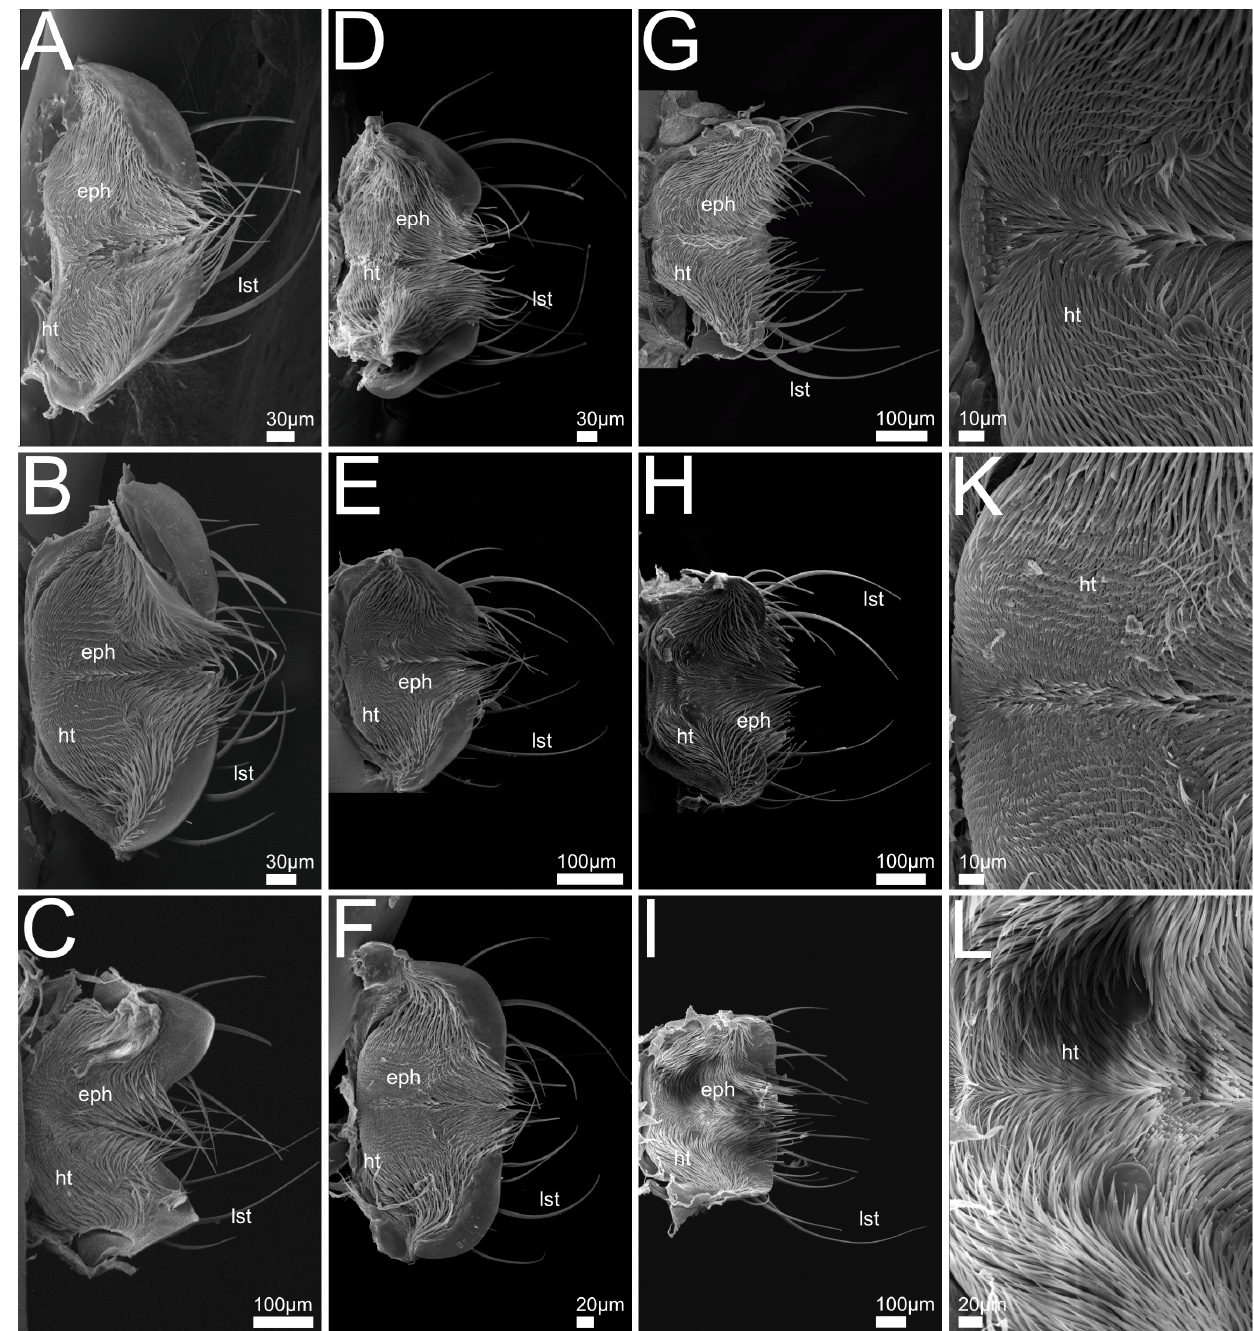
Figure 6. SEM views of Staphylinini labrum. Images A – I epipharynx, J – L with detailed views of medial area. ( A ) Bisnius sordidus ; ( B ) Philonthus varians ; ( C ) P. marginatus ; ( D ) P. rufipes ; ( E ) P. discoideus , ( F ) P. alpinus ; ( G ) Quedius cinctus ; ( H ) Q. cruentus ; ( I ) Q. curtipennis ; ( J ) P. discoideus ; ( K ) P. alpinus ; ( L ) Q. curtipennis . Abbreviations: eph: epipharynx; ht: hair-like trichomes; lst: long setae.